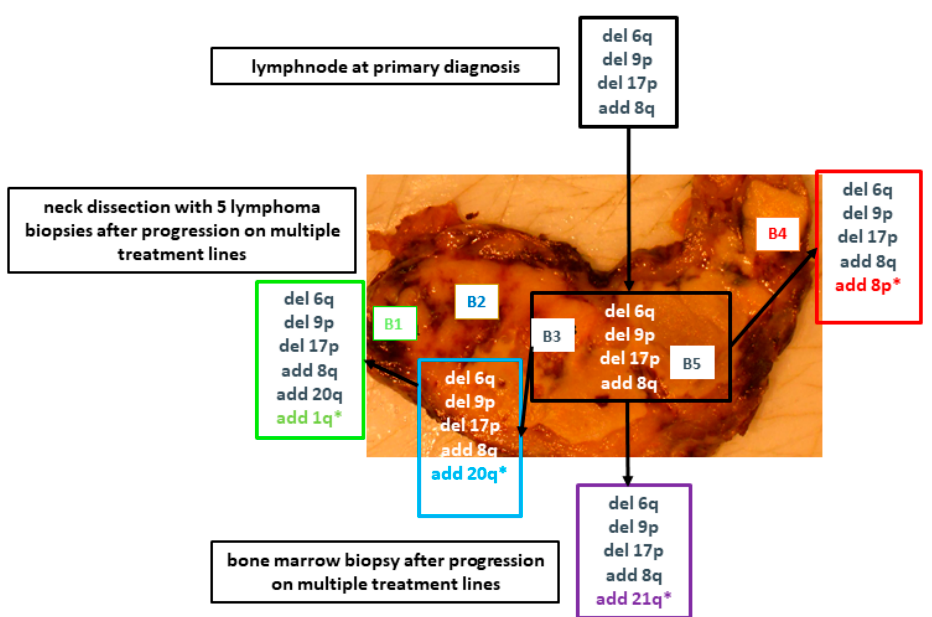
Figure 4. Seven biopsies of patient 5 and the detected copy number variants (CNVs). A biopsy of a single lymph node at primary diagnosis was available from this patient, which is shown at the top of the figure. The picture, in the middle of the figure, shows the specimen of the lymph node dissection which was carried out after the patient’s tumour progressed on multiple treatment lines. Shortly after the neck dissection, a bone marrow biopsy was performed and the results of the CNVs are shown at the bottom of the figure. All the samples share a complex genotype but additional CNVs (*) in some biopsies show both, spatial heterogeneity as well as clonal evolution over